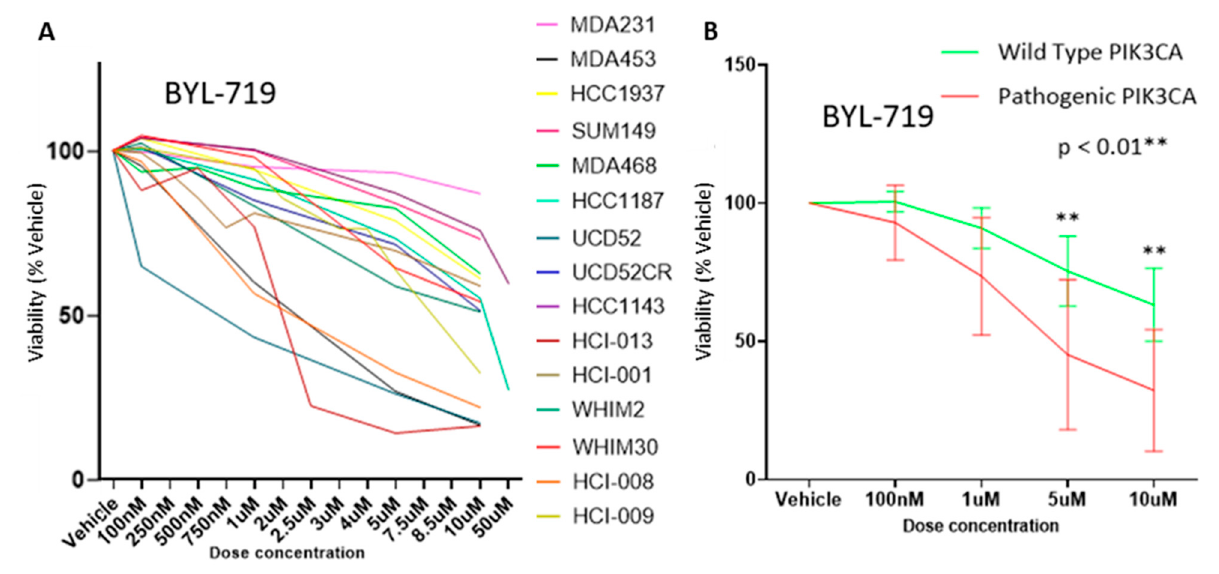
Figure 3. Pathogenic PIK3CA-containing models were more responsive to BYL-719. ( A ) Dose to viability by model in vitro. ( B ) Dose to viability by , grouped by PIK3CA oncogenic status.